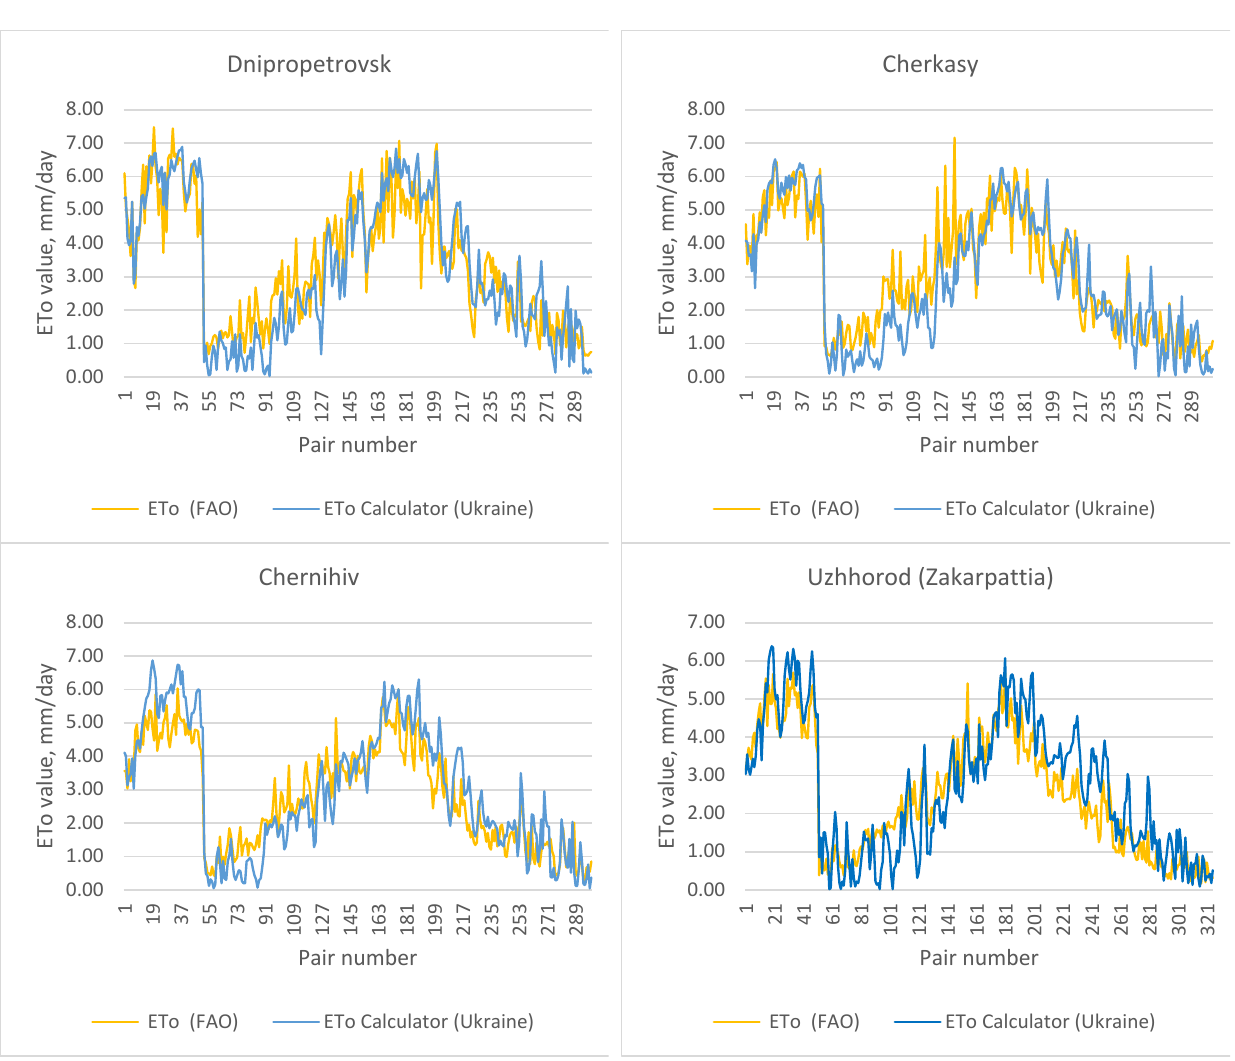
Figure 2. Reference evapotranspiration (mm/day) comparison between the standard FAO Penman– Monteith (Sherzod Rusmetov adaptation) and ETo Calculator (Ukraine) method by the studied regions of Ukraine (daily scale comparison). Table 2. Statistical indices of ETo Calculator (Ukraine) mobile app accuracy compared to Penman– Monteith method of reference evapotranspiration assessment (monthly